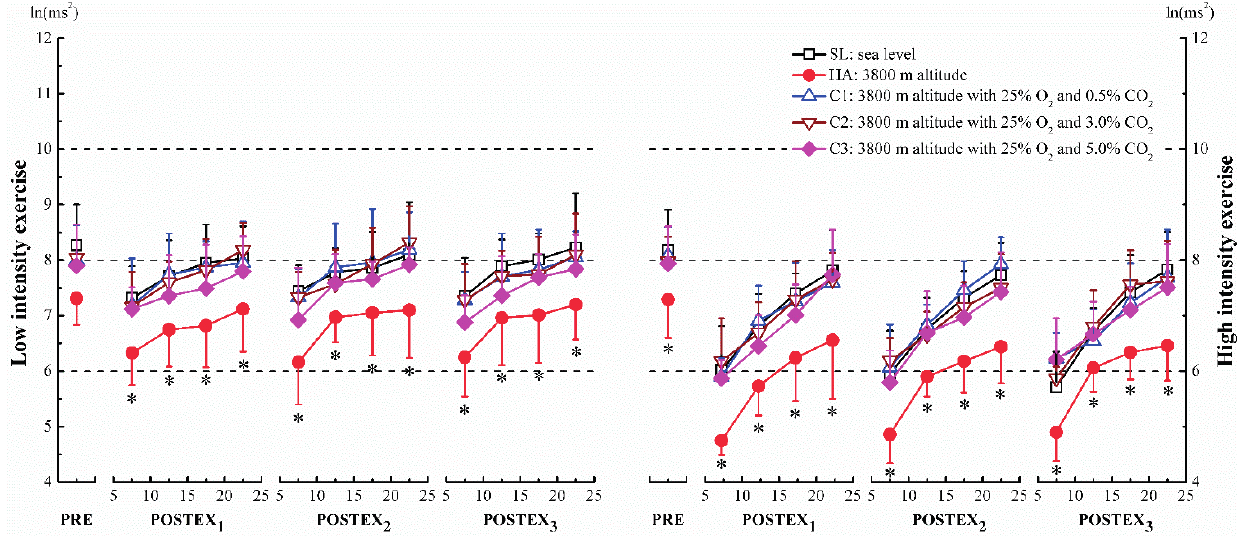
Figure 2. Total power (TP) in pre-exercise (PRE) and post-exercise (POSTEX 1 , POSTEX 2 and POSTEX 3 ). * p < 0.05, compared with SL in the same segment and exercise intensity.